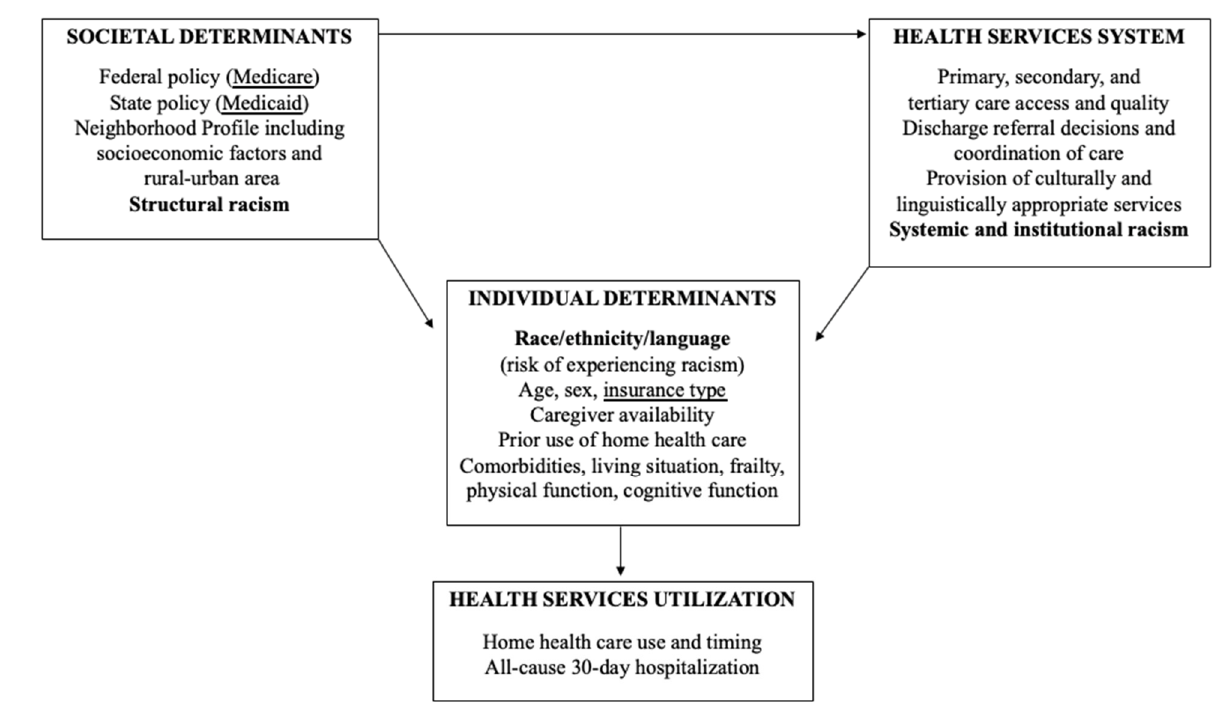
Figure 1. Conceptual model based on Andersen and Newman’s Framework for Viewing Health Services Utilization [18].